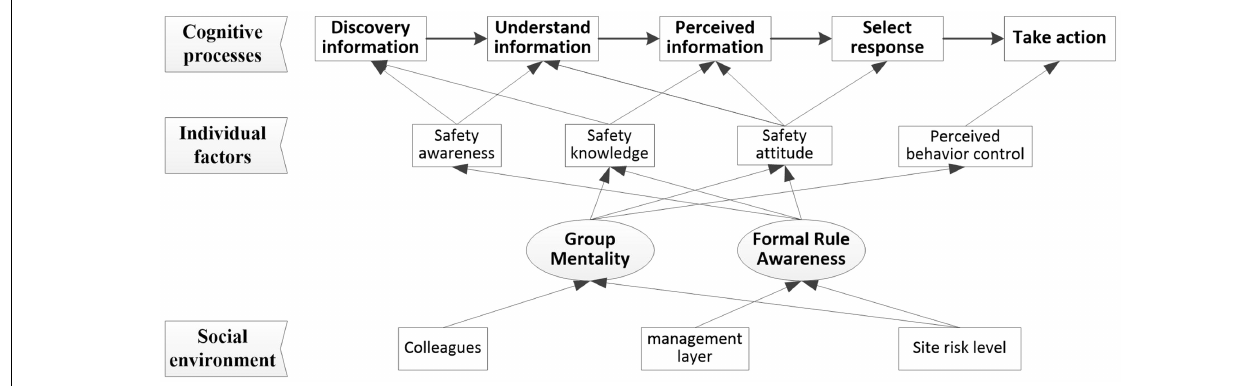
FIGURE 2 | Analysis on influencing factors of construction workers’ cognitive process.